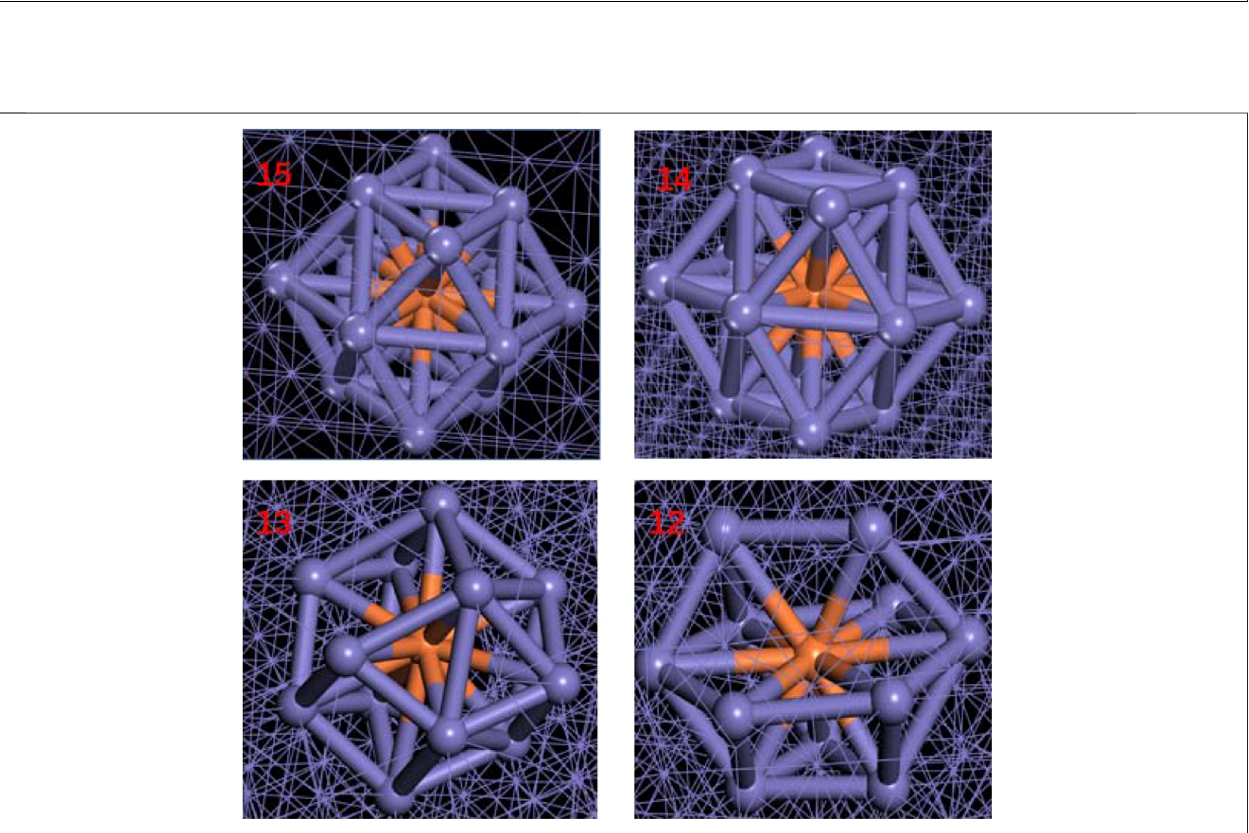
Frontiers in Materials |